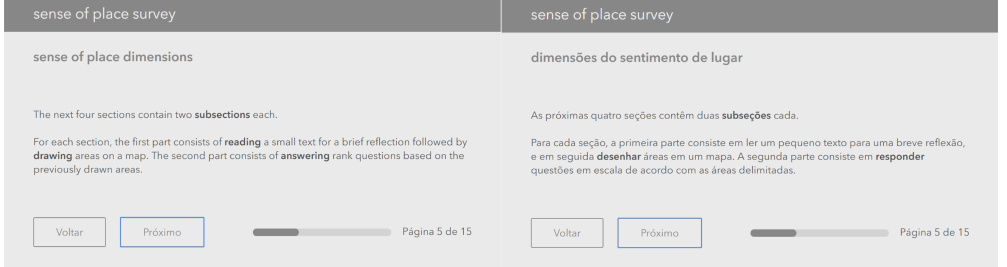
Figure 7: Brief explanation about following questions.